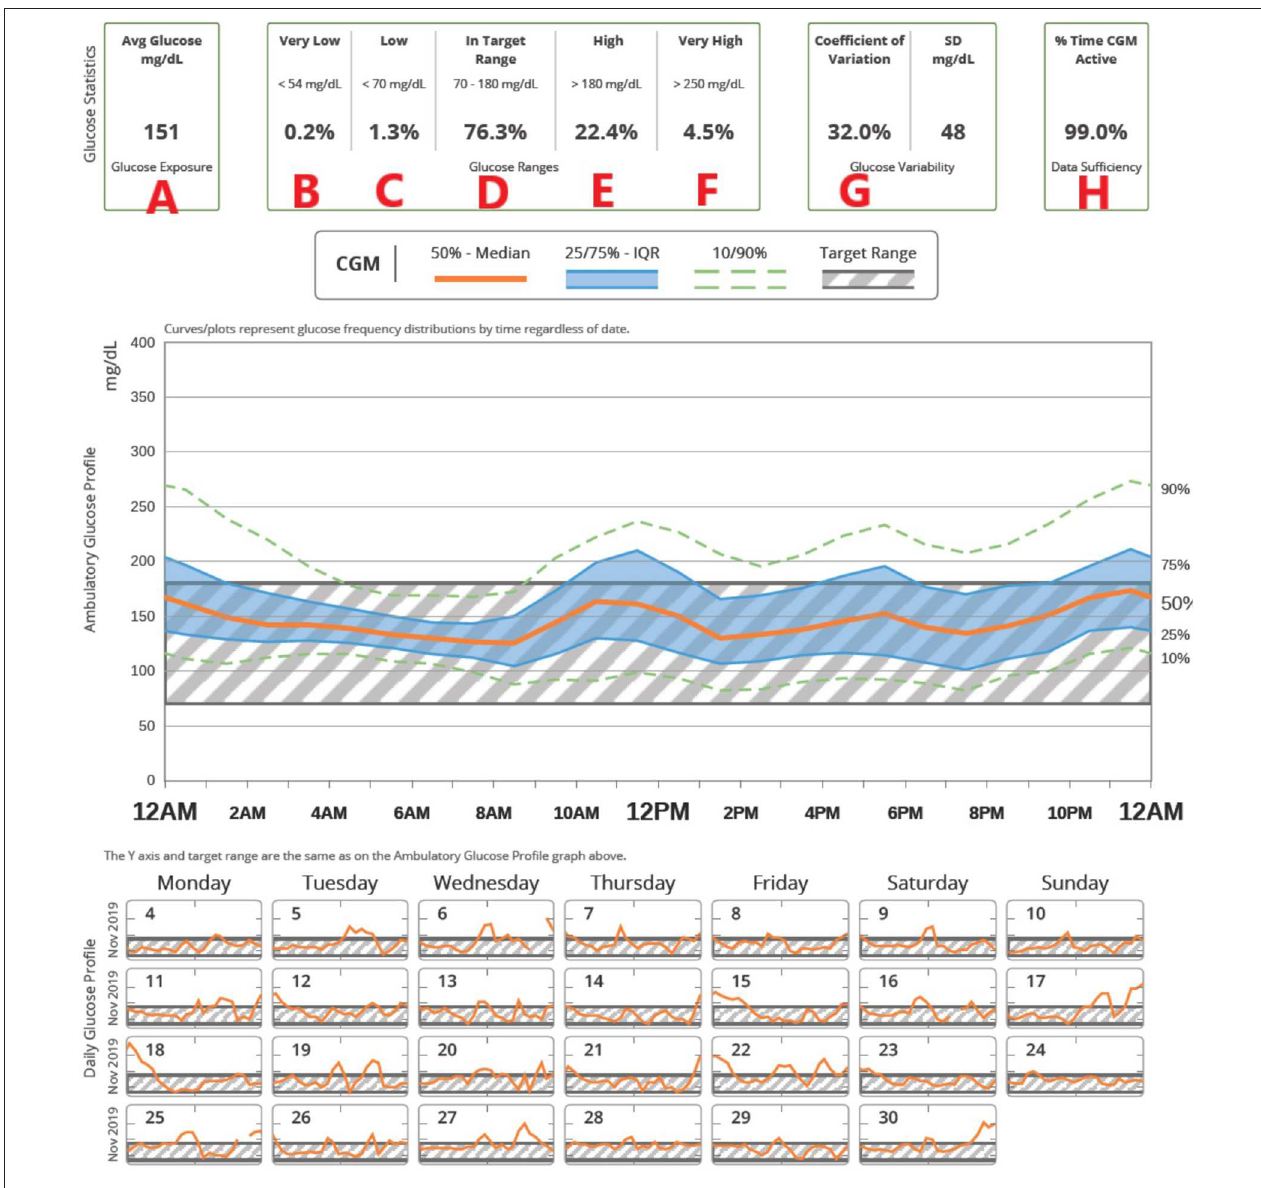
FIGURE 1 | An example of how CGM metrics are displayed in a standardized ambulatory glucose profile (AGP). (A) Average glucose, (B) Time very low ( < 54 mg/dL), (C) Time low ( < 70 mg/dL), (D) Time in target range (70–180 mg/dL), (E) Time high ( > 180 mg/dL), (F) Time very high ( > 250 mg/dL), (G) Coefficient of variation, (H) Percentage of time CGM is active. In the top figure, the hatched area shows the target range; composite data for 14-days are shown as median (orange line), interquartile range (blue shaded area), 10 and 90th percentiles (green dashed line). Individual days are shown